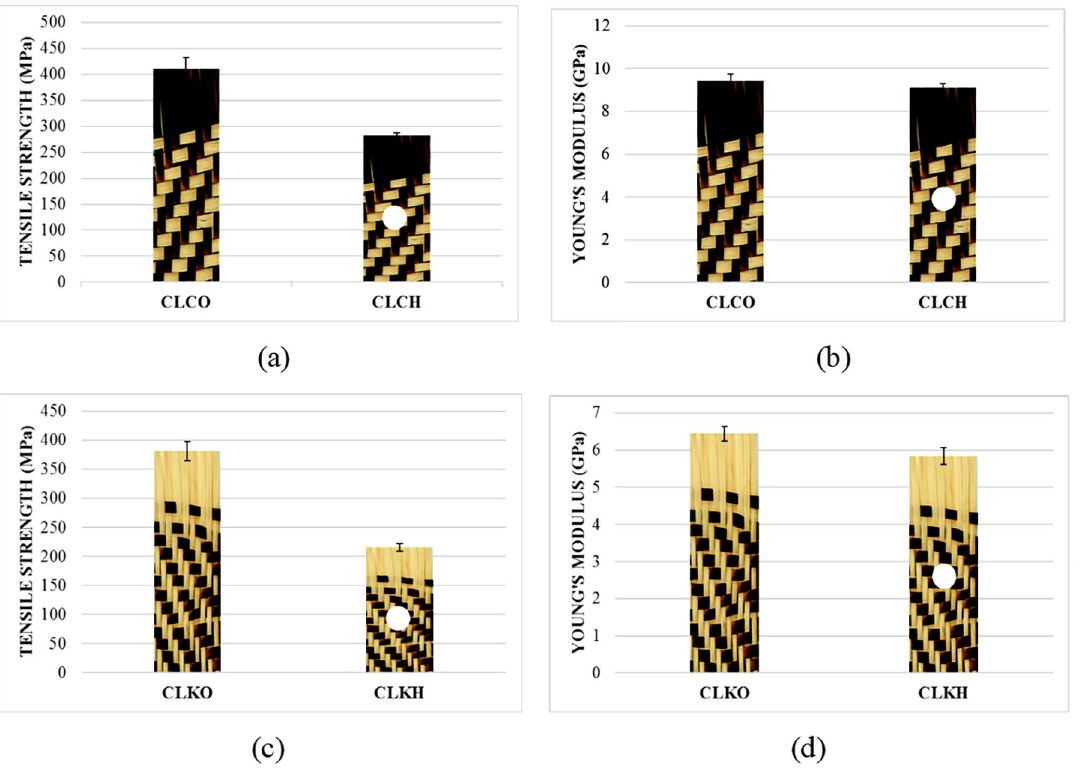
Figure 5. Comparative graph of the composite laminate ( CL ) as a function of the presence of a central hole. (a) and (c) Tensile strength. (b) and (d) Young’s modulus. Table 4. Percentage losses in mechanical properties due to the presence of a hole.